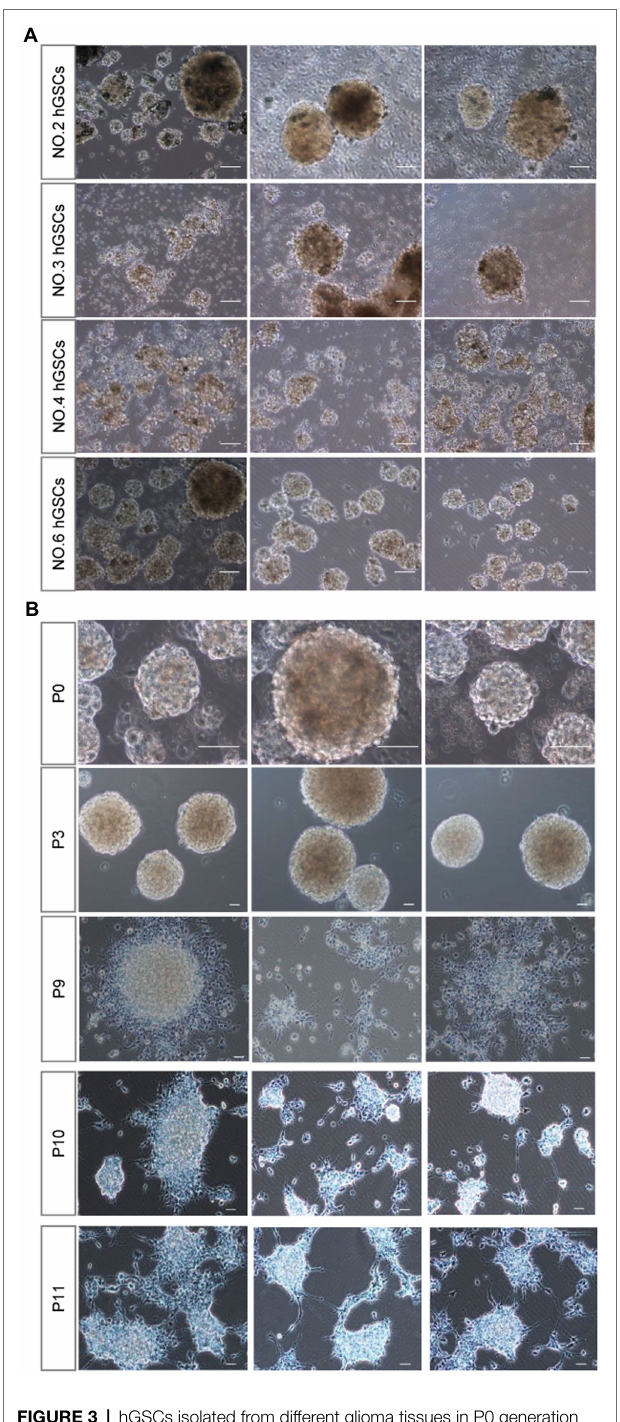
FIGURE 3 | hGSCs isolated from different glioma tissues in P0 generation and different generations from P0 after passage. (A) Representative images of hGSCs isolated from different individual glioma tissues in P0 generation. hGSCs were cultured in optimized culture conditions for 7 days. (B) hGSCs can be passaged for over 10 generations. Scale bar, 50 μ